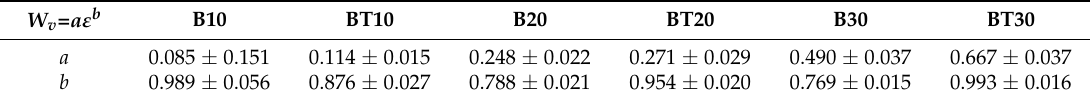
Table 4. The fitted resulted equation for energy absorption curves, given as means ± standard deviations (three replicate specimens).